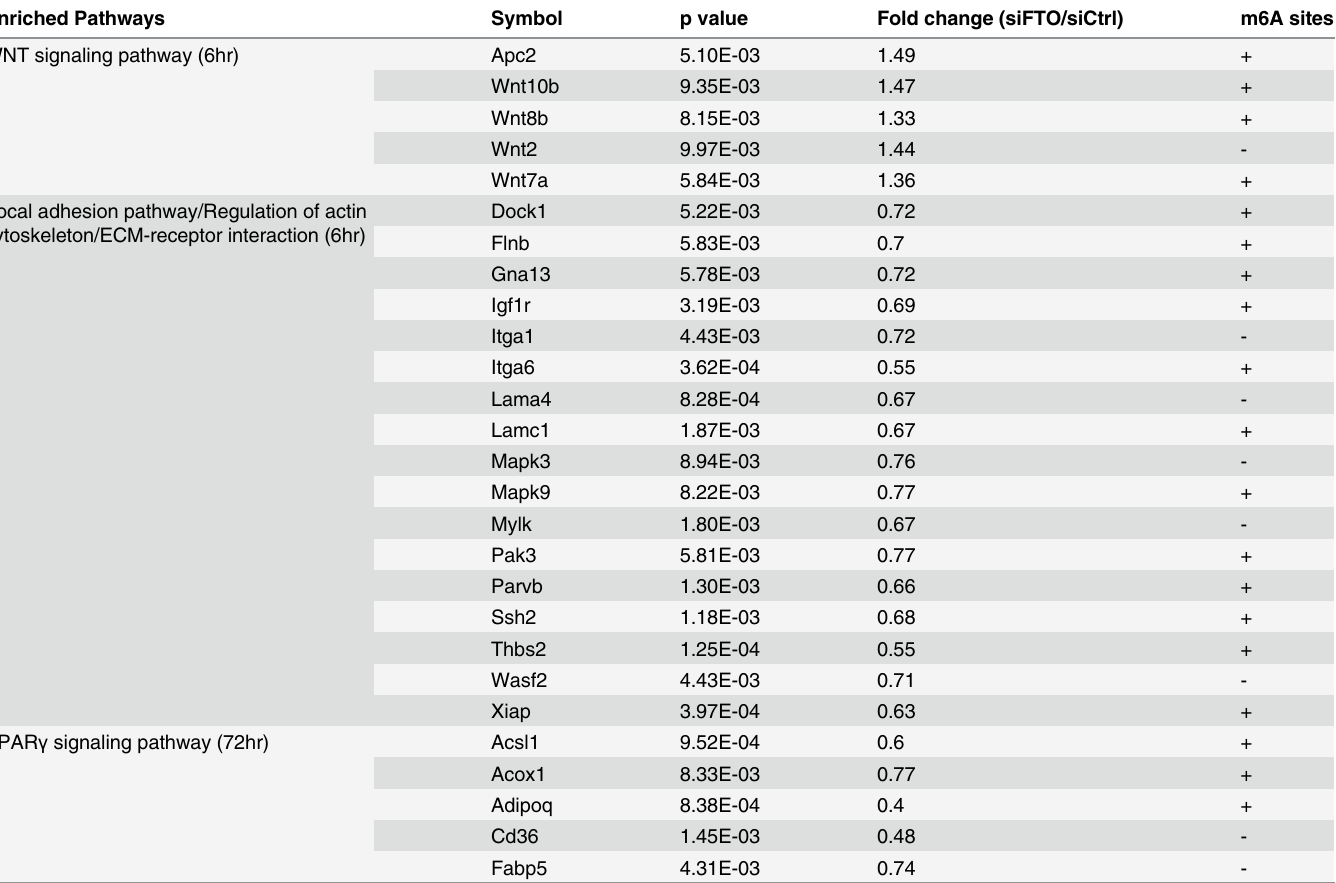
Table 1. Pathways significantly impacted by siRNA knock-down of FTO in 3T3-L1 cells at 6 hr and 72 hr post differentiation